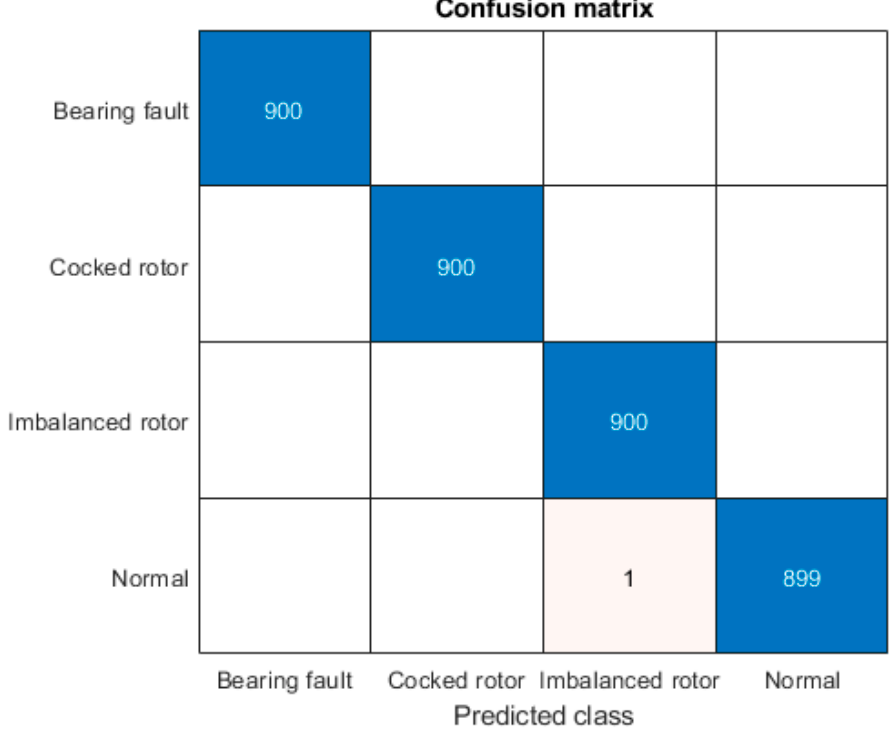
Figure 7. Frequency domain representations of kernels of first convolutional layer. Further on, distribution of all test samples extracted from input signal, each convolution layer and fully connected layer for the CNN_24–48 (bolded in Table 4) are given in Figure 8. Visualization is done by t-SNE van der Maaten and Hinton [39]. By looking at the input layer through convolutions, it can be clearly seen that activations computed by learned kernels in high dimensional space can be successfully clustered via t-SNE in clusters representing classes in two dimensions as evolving to the fully connected layer.